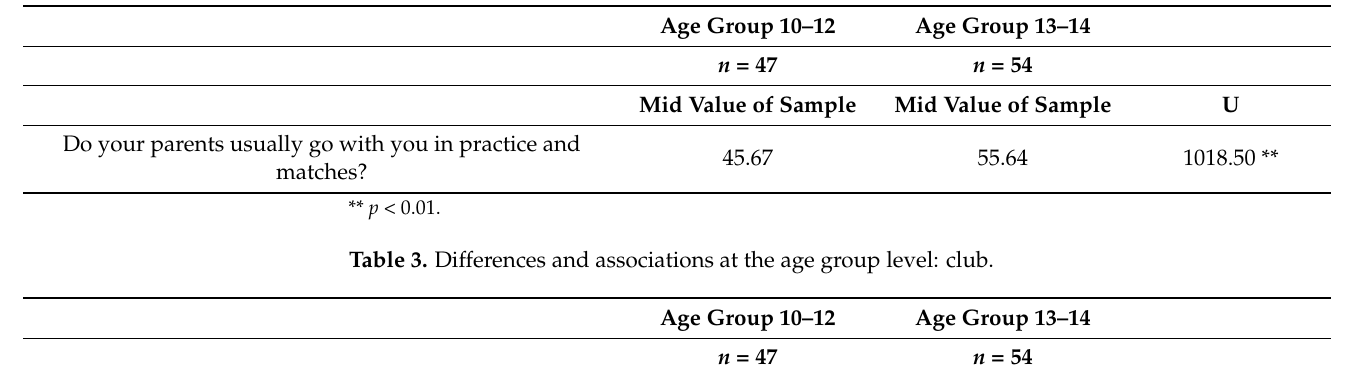
Table 2. Differences and associations at the age group level: sports practice.